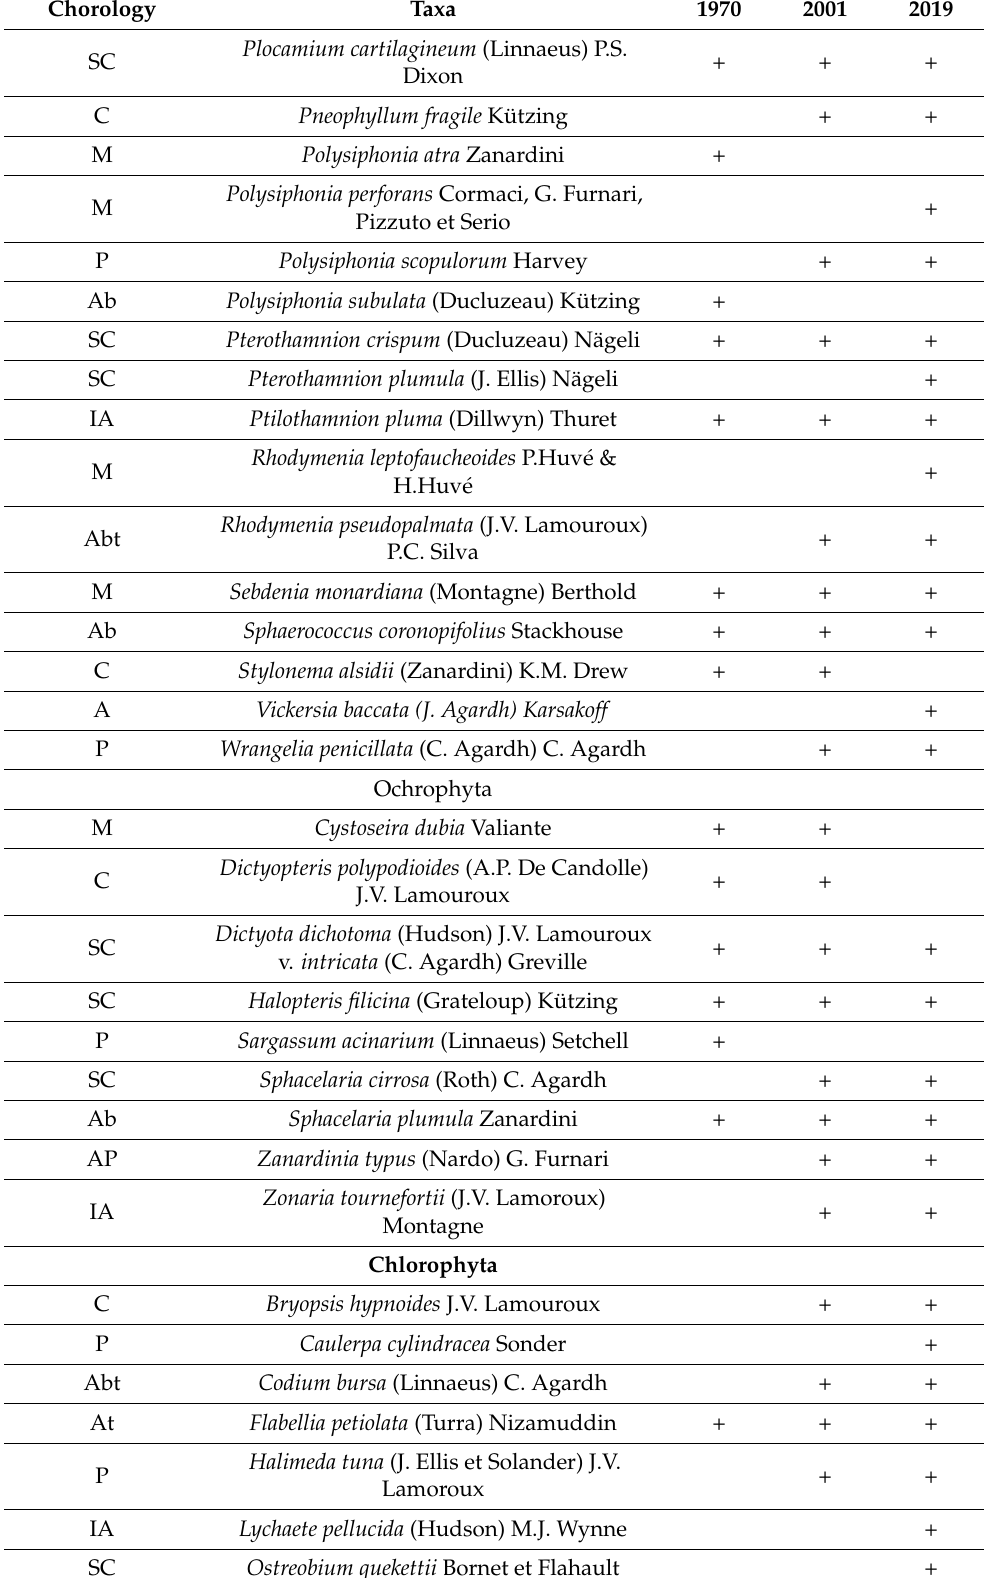
Table 2. Cont. Chorology Taxa Plocamium cartilagineum (Linnaeus) SC